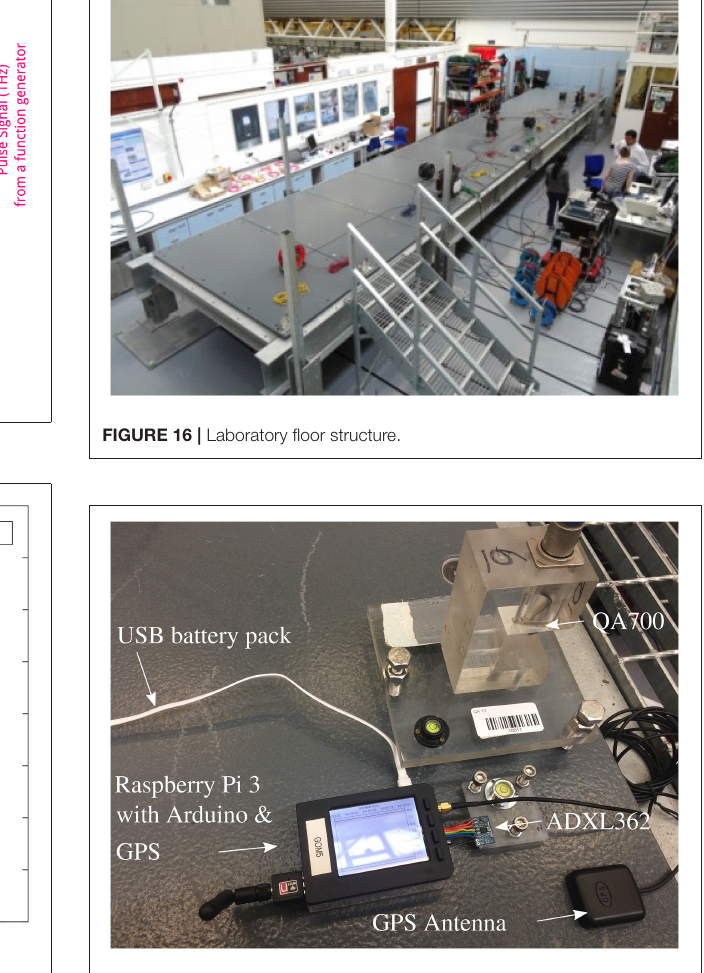
FIGURE 17 | Wireless and Wired sensor: (top-right) wired QA700 accelerometer, and (bottom-middle) wireless ADXL362 MEMS